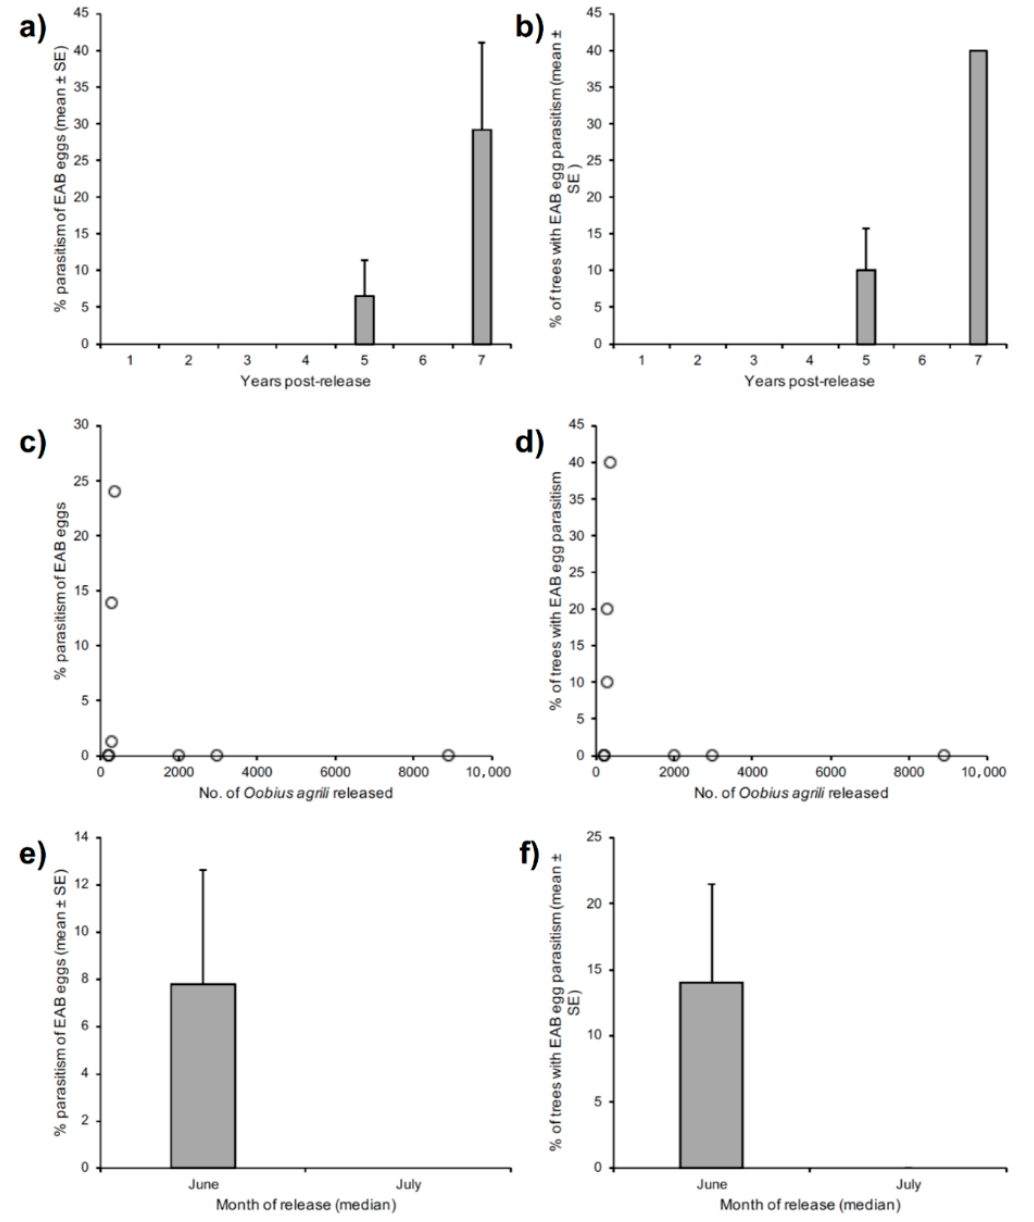
Figure 2. Mean percent parasitism per tree, and mean percentage of trees with parasitized emerald ash borer eggs, by years-post release ( a , b ), total number of parasitoids released ( c , d ), and median month of release ( e , f ), across the nine recovery sites. Data pooled from both survey methods. Black lines represent standard error.